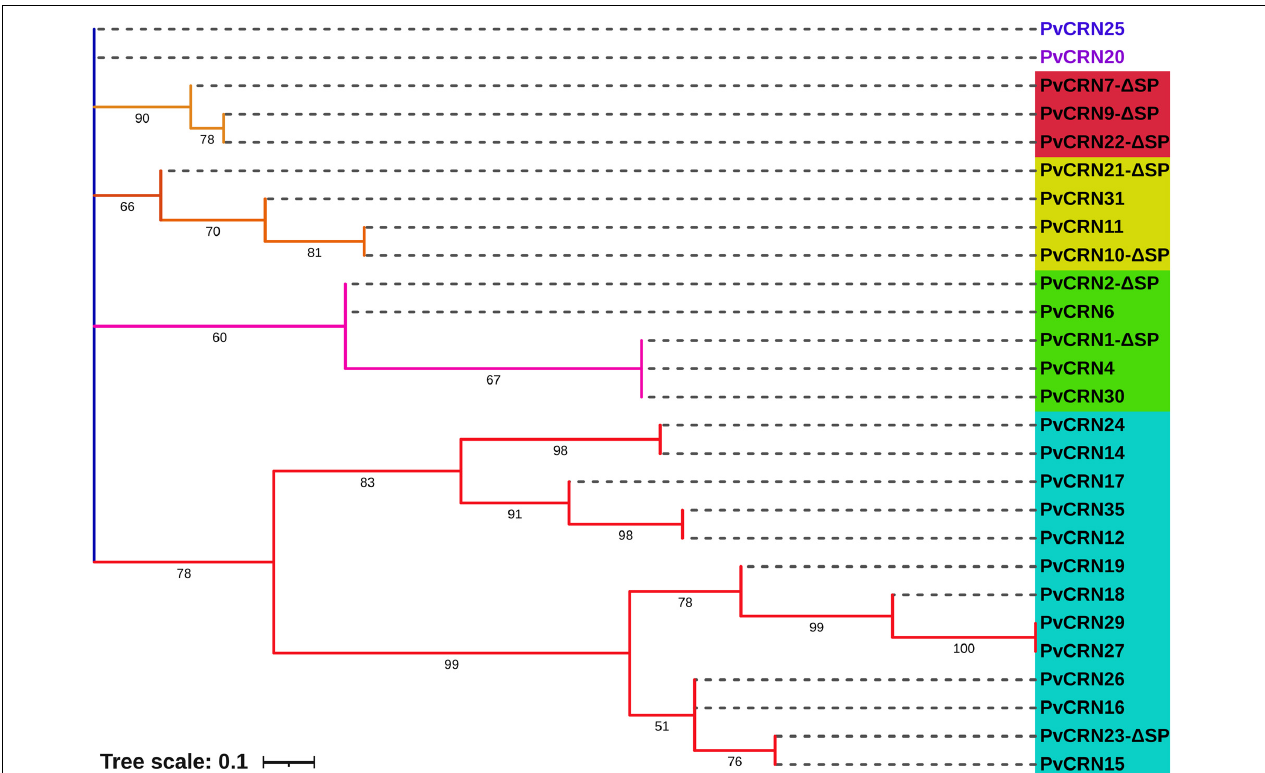
FIGURE 1 | Phylogenetic relationships among the PvCRN genes of P. viticola isolate YL. The phylogenetic tree was originally generated in MEGA7.0 using the maximum likelihood method with 1,000 bootstrap replicates. The optimal substitution model was WAG + G. Different subgroups are highlighted with different colors, and bootstrap values greater than 50 are indicated on the